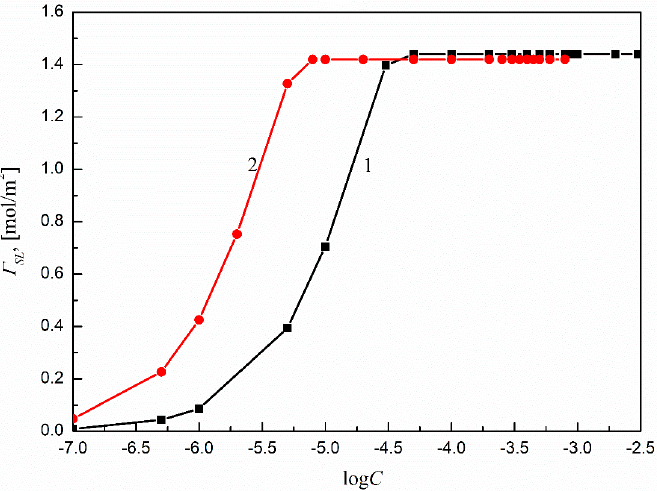
Figure 5. A plot of the SMD (curve 1) and SML (curve 2) Gibbs surface excess concentrations ( Γ at the Ti6Al4V ELI–water interface vs. the logarithms of surfactant concentration (log C S ). The relative amount of the surfactant at the solid–water interface can be also calculated by means of the Lucassen–Reynders equation [17]. For that, the dependence between the adhesion tension ( γ LV cos θ ) and the surface tension ( γ LV ) of the surfactant solution can be used. To determine the relative amount of surfactant in the studied range of concentration, this relation should be linear. Thus, in our studies the relationships between 𝛾 (cid:3013)(cid:3023) 𝑐𝑜𝑠𝜃 and 𝛾 (cid:3013)(cid:3023) for SMD and SML were determined, and obtained results are presented in Figure 6.